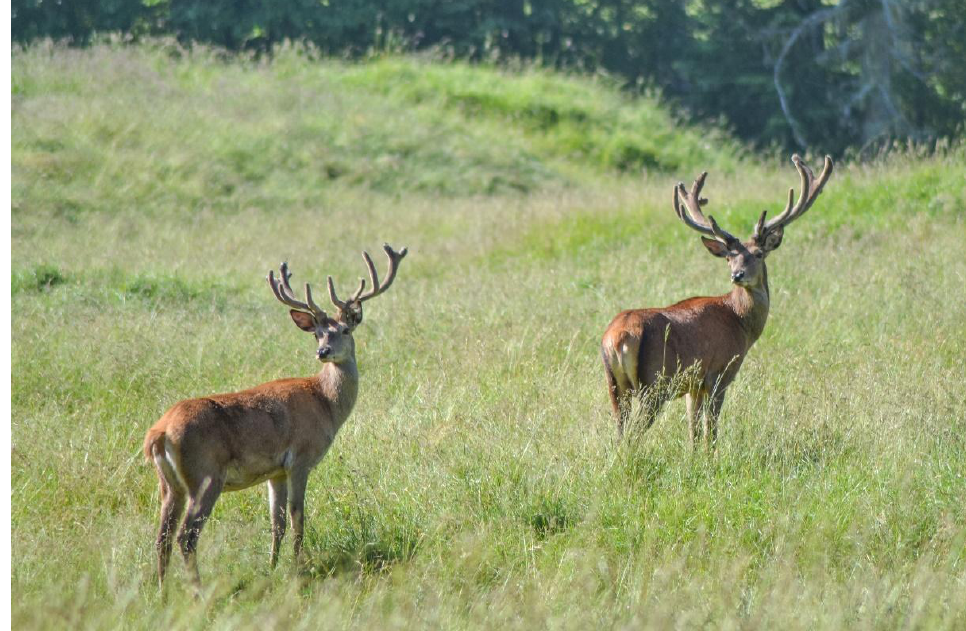
Figure 7. Two males stopping and looking back to the source of disturbance while fleeing. With poor visibility conditions, animals were less sensitive to disturbances. During